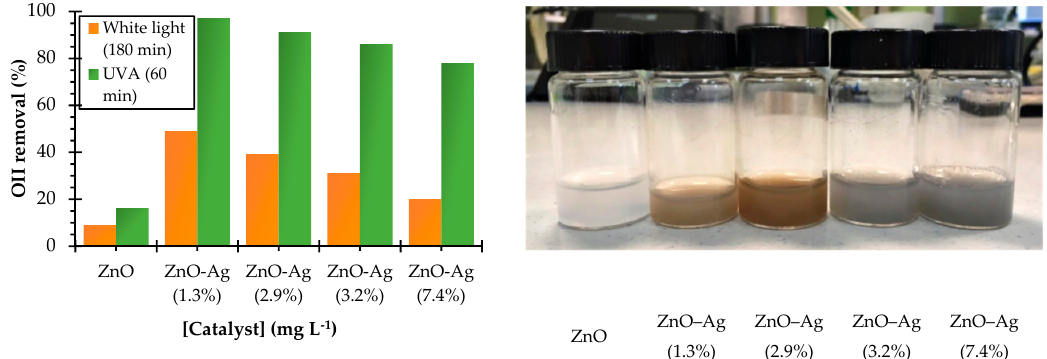
Figure 4. Silver loading effect on photocatalytic performance. The values in brackets correspond to the percentage of Ag in each NC ( left ); Aqueous suspensions of ZnO-NPs and ZnO–Ag NCs with different silver loadings ( right ).